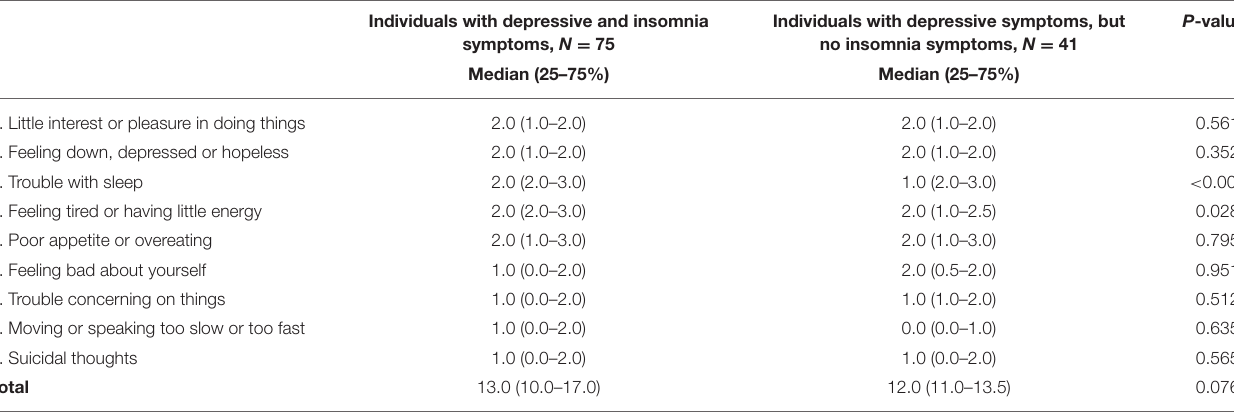
TABLE 2 | Total and item scores of the PHQ-9 among individuals with depressive symptoms according to the presence of insomnia symptoms. P -value* Individuals with depressive and insomnia Individuals with depressive symptoms, but symptoms, N = 75 no insomnia symptoms, N = 41 Median (25–75%) Median